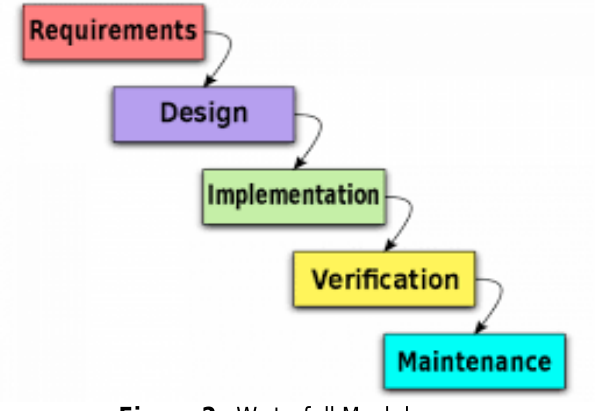
Figure 2. Waterfall